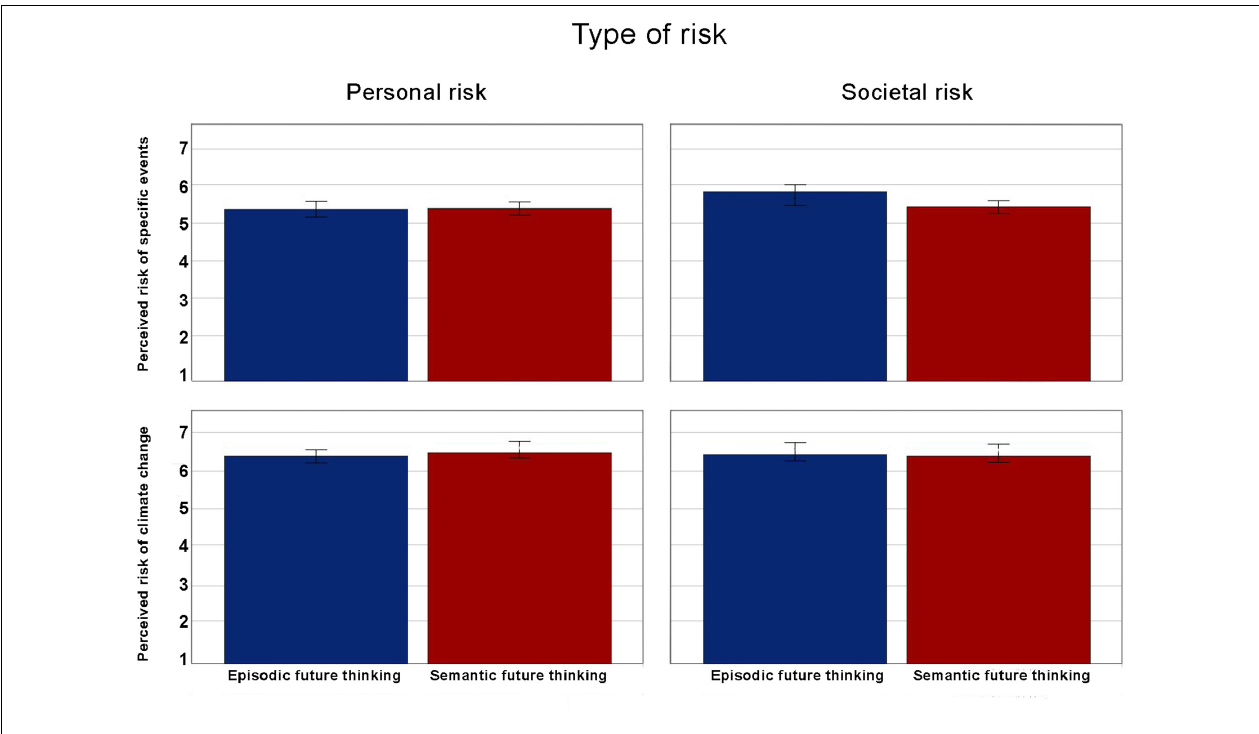
FIGURE 3 | Main effect of future thinking on perceived risk measures. TABLE 3 | Overview of perceived risk scores on different outcome measures for the different conditions. Episodic future